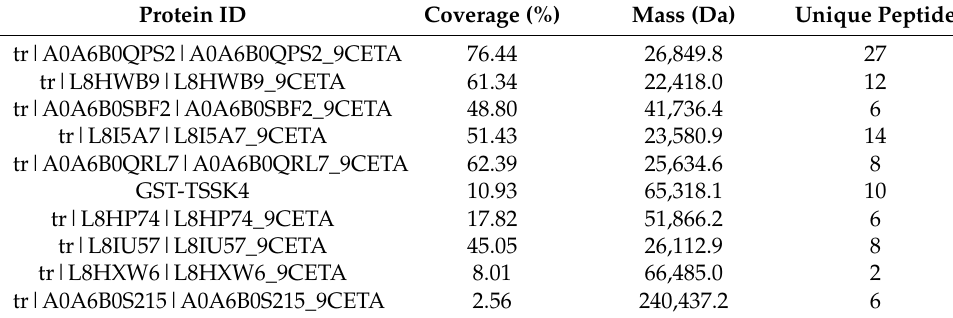
Table 6. Protein-related information